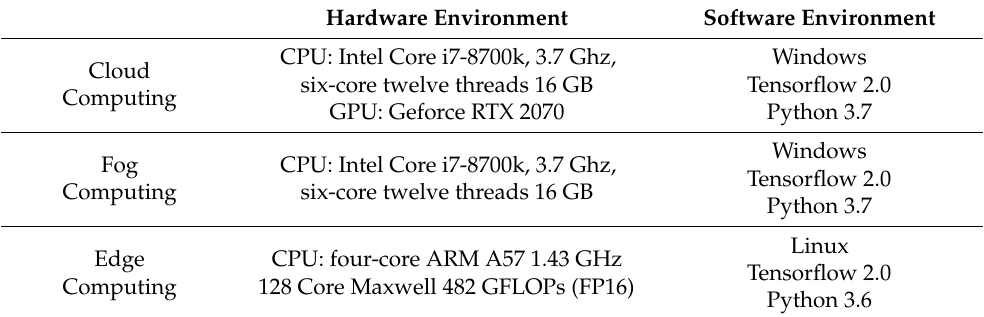
Table 2. The experiment environments.